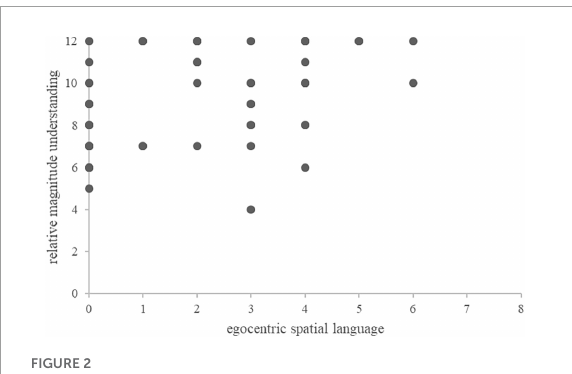
FIGURE2 Scatter plot illustrating the correlation between children’s use of egocentric spatial language and their relative magnitude